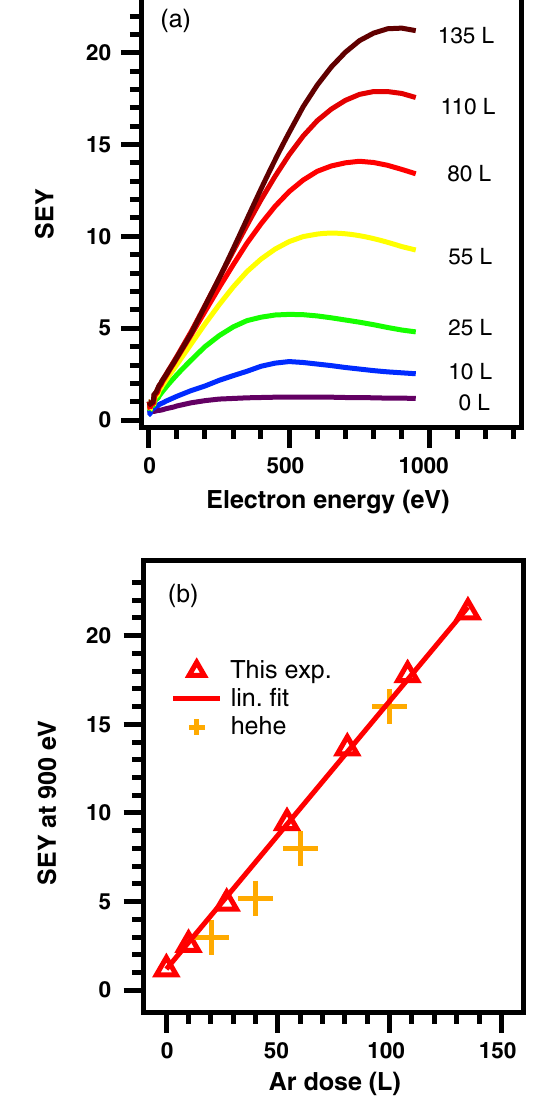
FIG. 3. (a) Secondary electron yield (SEY) curves measured for increasing Ar doses on the flat poly-Cu sample. (b) Triangles indicate the trend obtained from the curves in panel (a), plotting the SEY value at 900 eVas a function of Ar dose. Cross symbols refer to data extrapolated from data by Cazaux et al. [51]. The solid line, in panel (b), indicates the best fit curve of the experimental points obtained using Eq.